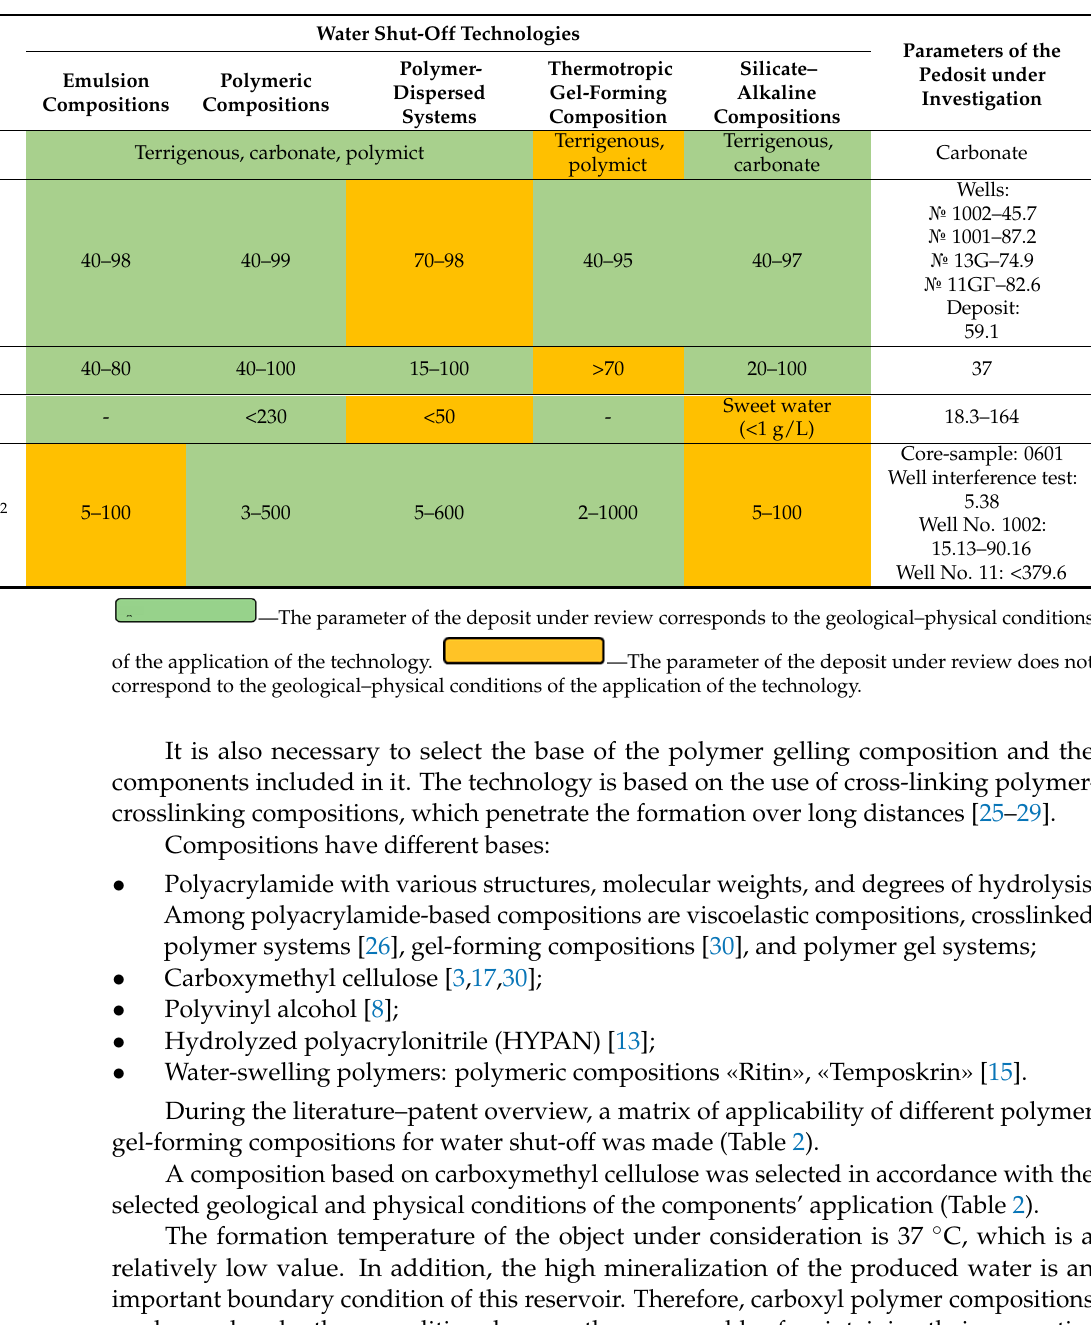
Table 1. Matrix of applicability of water shut-off technologies considering the main geological, physical, and field parameters. Compiled by the authors.